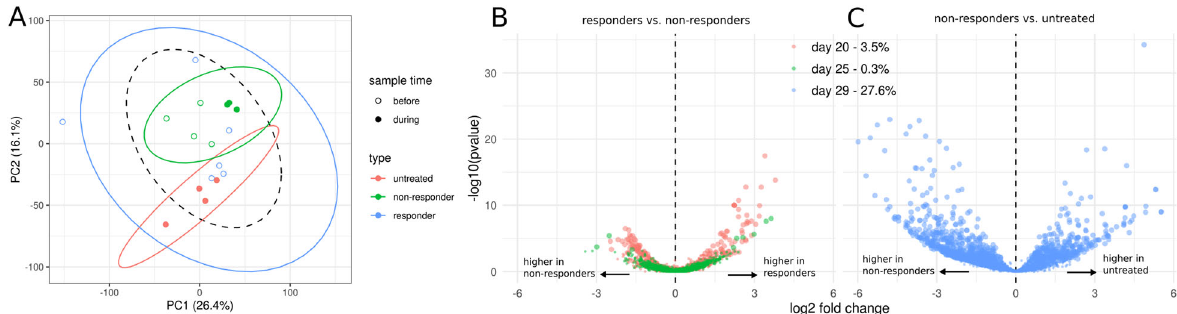
Fig. 4 Global transcriptional response to antibiotics in non-responder phenotypes. A Principal component analysis (PCA) of RNA-seq samples based on abundances of orthologous protein clusters. Percentages in brackets denotes explained variance. Symbol fi ll denotes sampling time relative to antibiotic treatment and colors denotes response type. Ellipses denote 95% con fi dence interval from a Student ’ s t -distribution. Dashed ellipse describes samples taken before antibiotic exposure. B , C Volcano plots of pre-treatment responder vs. non-responder samples ( B ) and non-responder samples during treatment vs. untreated samples ( C ). Each dot denotes a differential abundance test for a distinct SEED cluster of orthologous proteins. Percentages for each day denote positive tests rate (number of signi fi cant tests/total tests) and colors denote the day the samples were taken (days 20 and 25 were before and day 29 was during antibiotic treatment). Tests with FDR q values < 0.05 are shown as larger dots, whereas non-signi fi cant results are shown as small dots.